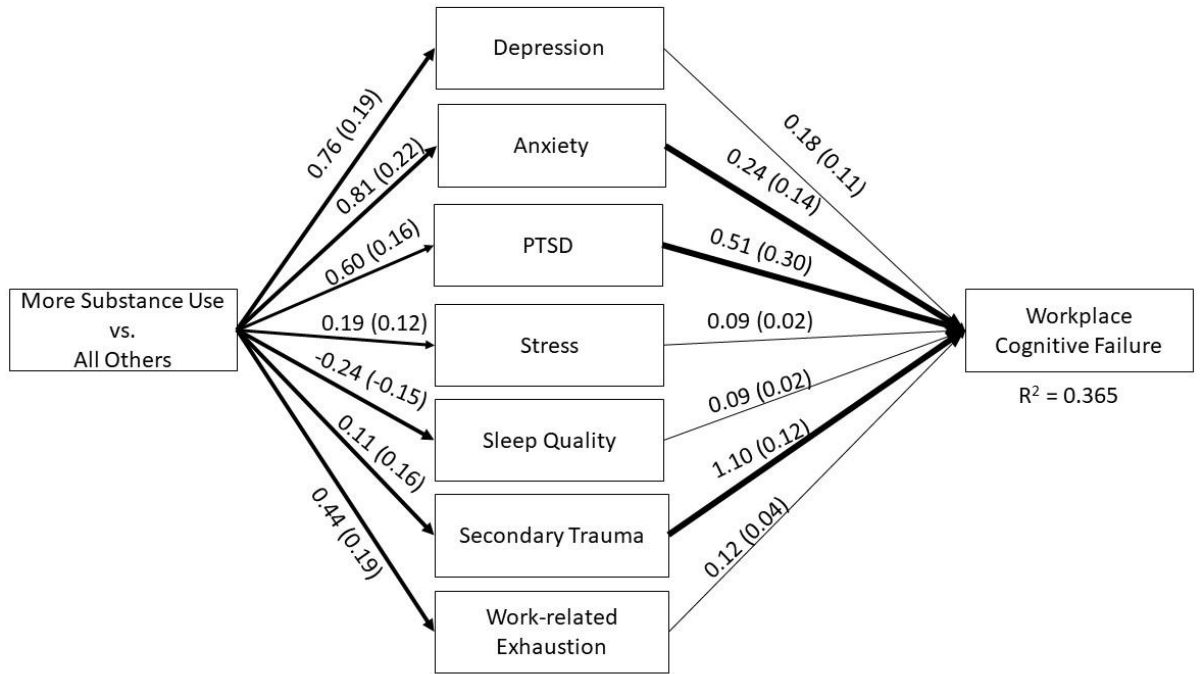
Figure 1. A summary path diagram of the hypothesized model testing the effects of reported increased substance use on workplace cognitive failure via multiple psychological mediators. Unstandardized coefficients (standardized coefficients) are reported for each path; bolded paths indicate statistical significance ( p < 0.05). The cumulative model accounted for 37% of the variability in the outcome. Of the cumulative effect of increased substance use on workplace cognitive failure, 86.48% was mediated. Although all hypothesized factors contributed to the model, not all paths were statistically significant: greater anxiety (b = 0.236, z = 2.22, p = 0.027), greater